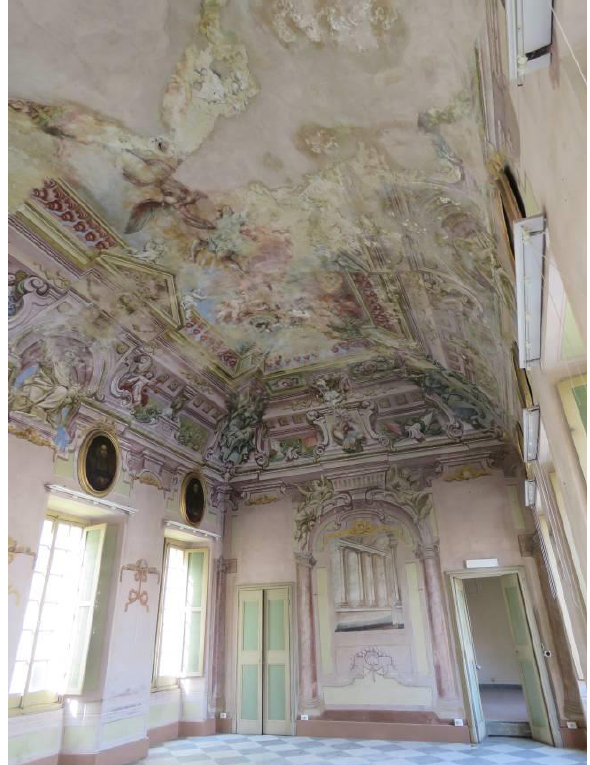
Figure 1. Family Portrait Room on the second noble floor of the Palace Borea d’Olmo, Sanremo